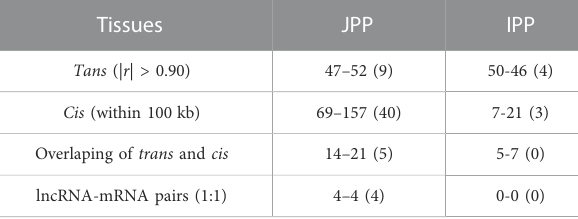
TABLE 1 Statistics of trans and cis analysis [DE lncRNA-mRNA (DE mRNA)].